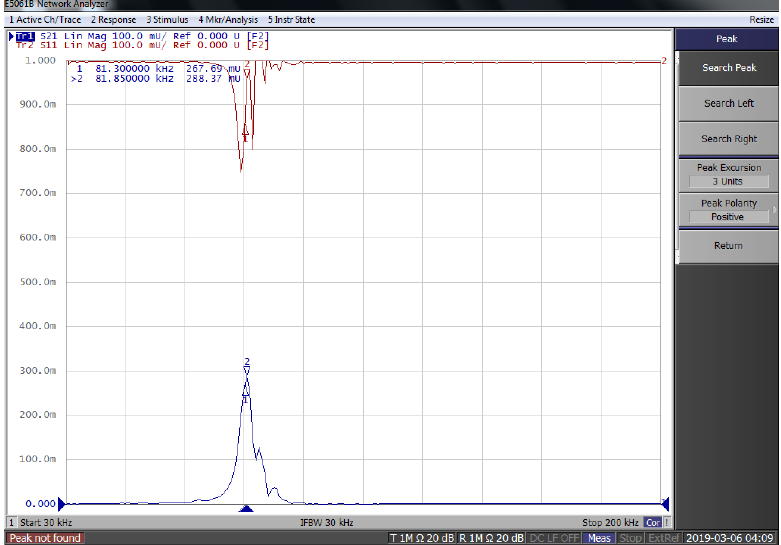
Figure 10. The curve of the four-coil MCR-WPT system S 21 , when α = β =